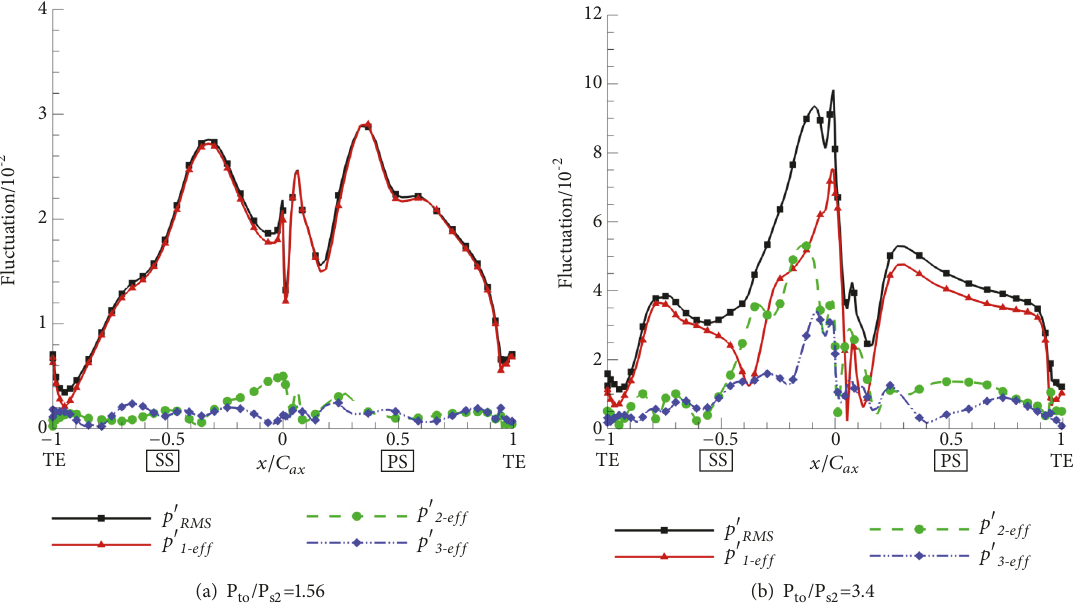
Figure 8: Unsteady pressure amplitude distribution along rotor blade surface at